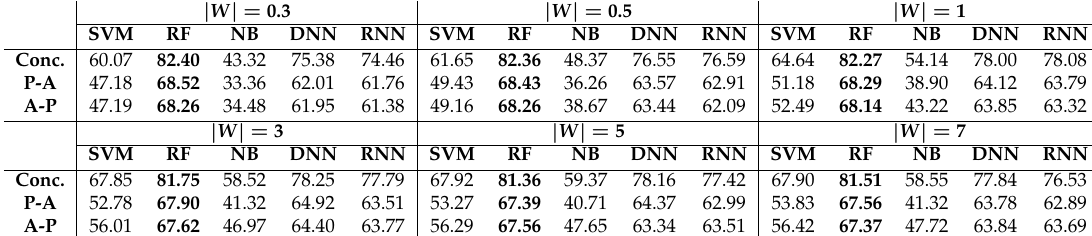
Table 9. Accuracies of concurrent, possession-action, and action-possession recognition for different lengths of